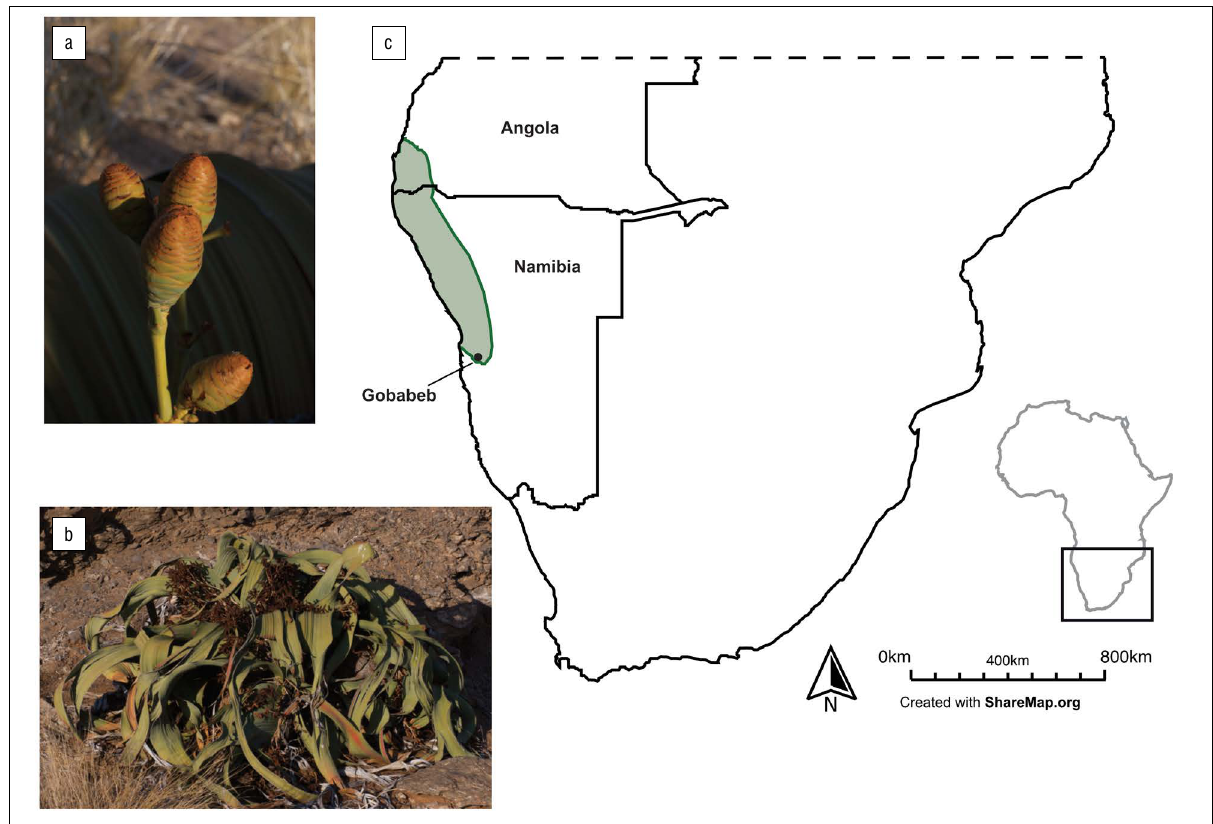
(a) Female seed cones of Welwitschia mirabilis . (b) Male Welwitschia mirabilis with pollen cones. (c) Geographic distribution of Welwitschia mirabilis in Angola and Namibia. The sampling site near Gobabeb is